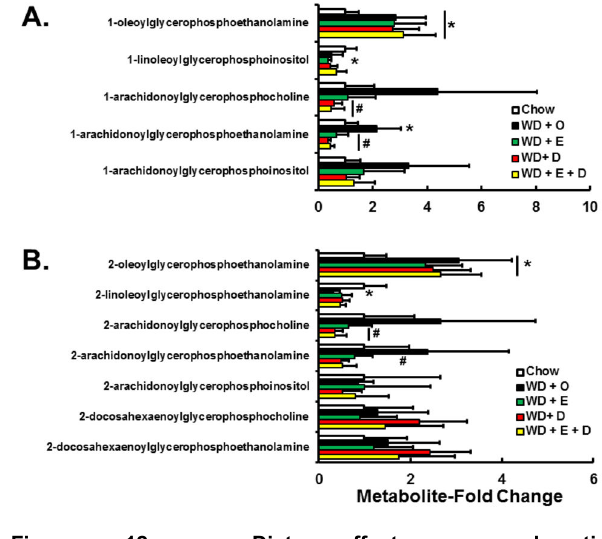
Figure 12. Diet effects on hepatic lysophospholipids. Panels A and B: Lysophospholipids were fractionated and quantified by the metabolomic analysis (LC/MS) as described in the Methods. Panel A: Lysophospholipids with acyl chains in the sn-1 position; Panel B: Lysophospholipids with acyl chains in the sn-2 position. The lysophospholipids are represented as Metabolite-Fold Change relative to chow; mean ± SD; n=8/group; *, P ≤ 0.05 versus chow; #, P ≤ 0.05 versus WD + O. doi: either de novo phospholipid synthesis or remodeling of membrane phospholipids. We examined the expression of enzymes involved in membrane remodeling; including four lysophosphatidylcholine acyl transferase subtypes (LPCAT1-4) and two phospholipase subtypes (iPLA2γ and PLA2γ6) (Figure 13 ). WD + O induced transcripts encoding all LPCAT subtypes (> 30%), while WD + D suppressed LPCAT1, 2, and 4 expression. The phospholipase, iPLA2γ, was unaffected by diet, while PLA2γ6 was induced (~2-fold, p<0.05) by the WD + O, regardless of the presence or absence of dietary C n-3 20-22 PUFA. Overall, this analysis showed that diet-induced changes in hepatic membrane lipid composition are influenced by substrate availability for membrane phosphoglycerolipid synthesis, as well as changes in the expression of enzymes involved in membrane remodeling. Oxidized PUFA and lipid peroxidation PUFA are sensitive to enzymatic and non-enzymatic mono- oxidation (Figure 14 ). Enzymatic oxidation involving cyclooxygenases (COX), lipooxygenases (LOX) and CYP2 family members requires excision of the fatty acyl chain from membranes by phospholipases, while non-enzymatic lipid peroxidation likely results from increased hepatic oxidative stress affecting membrane PUFA. The metabolomic analysis identified several oxidized PUFA generated from 18:2,n-6, 20:4,n-6 and 20:5,n-3 (Figure 15 ; Tables S2 - S4 ). The prostaglandin (PG), 6-keto-PGF1α, was only detected in WD +